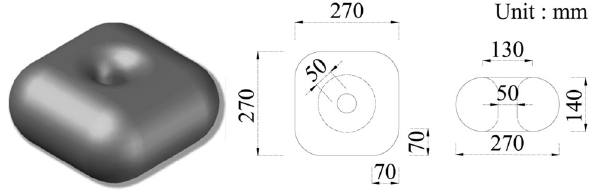
Fig. 1 Details of the donut type void former.